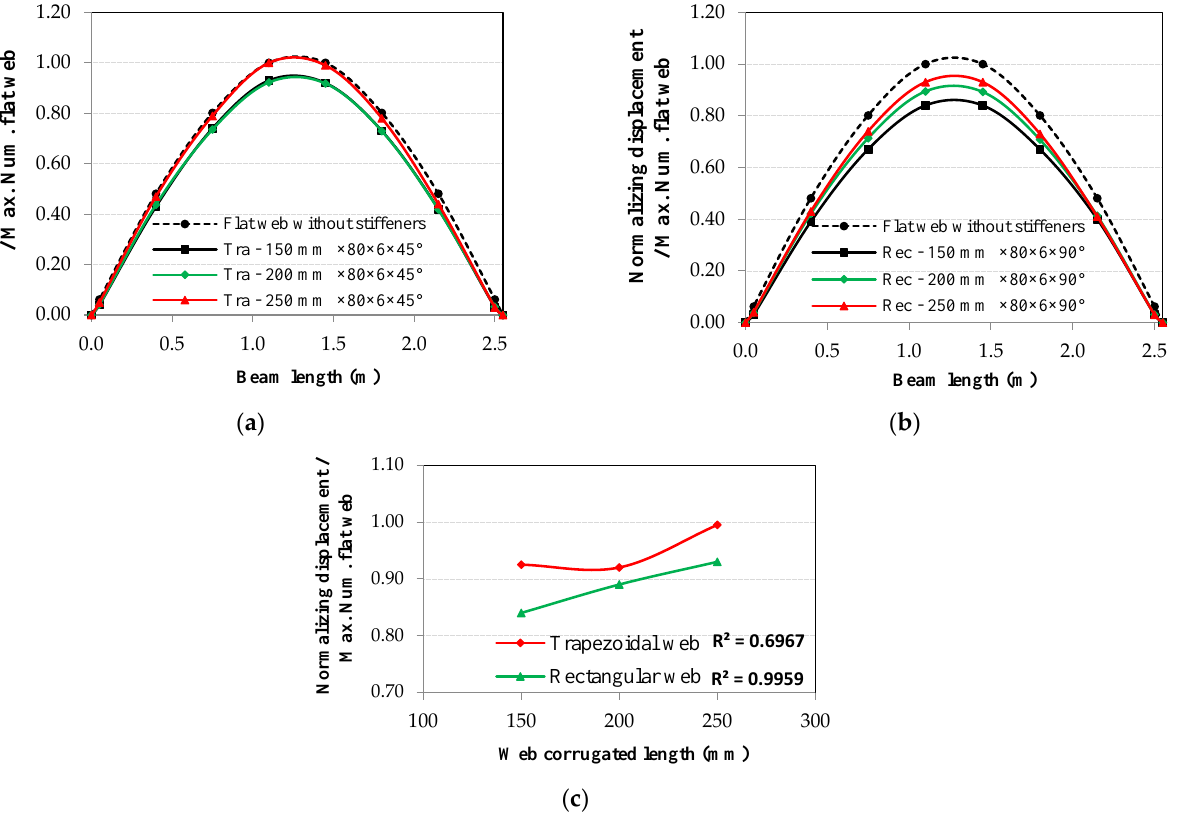
Figure 15. Corrugated length effect on the relationship between normalized displacement and beam length for the 1st mode shape: ( a ) trapezoidal web, ( b ) rectangular web, and ( c ) length effect at the 1st mode shape.